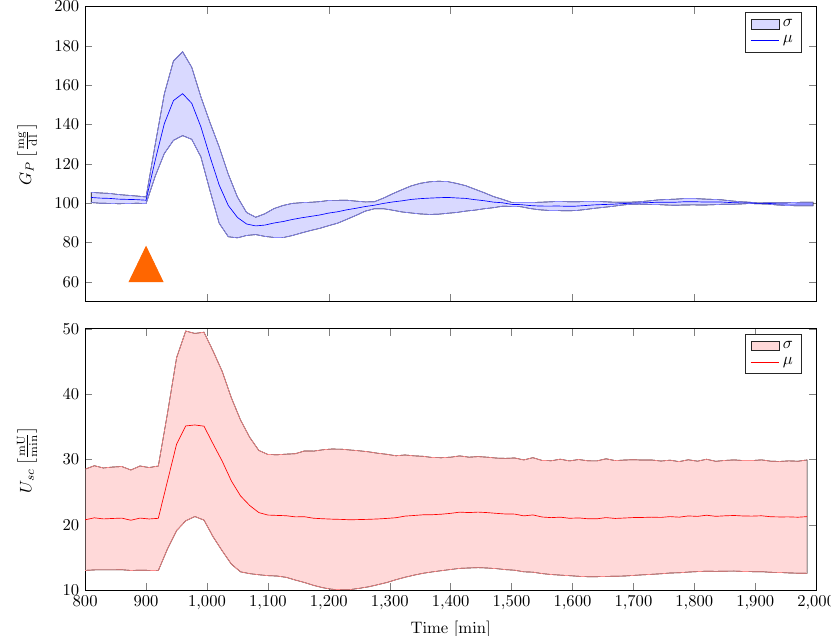
Figure 12. Disturbance rejection statistics with single robust gain-scheduled controller that stabilises the family of Göttingen Minipig model. In this figure, 50 mg CHO are given to the minipig at a time t = 900 min, indicated by an orange triangle ( µ —average mean, σ —standard